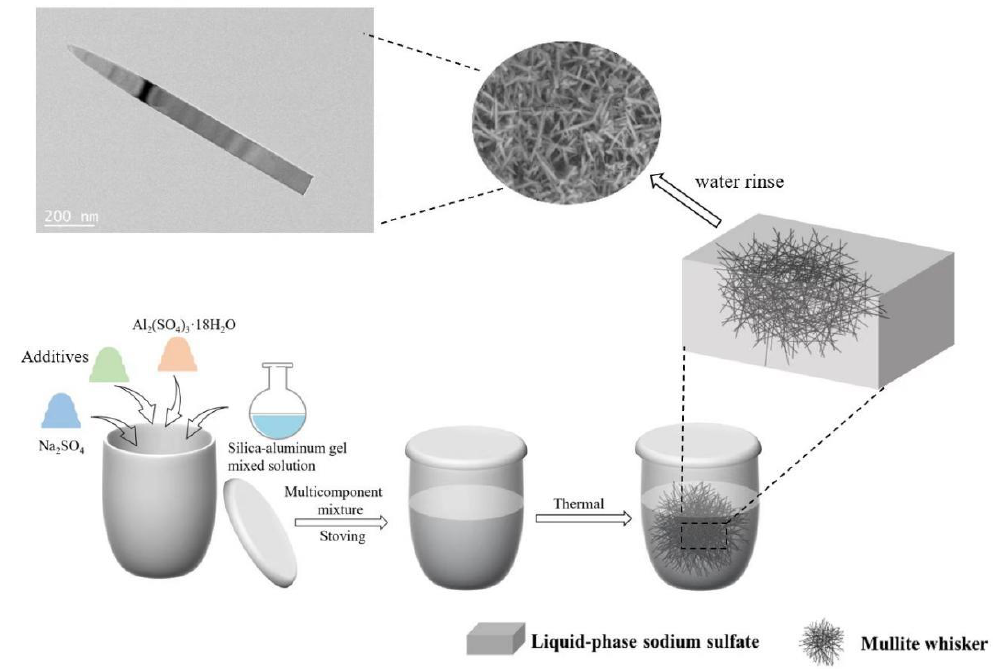
Figure 1. shows the flow chart for the preparation of mullite whiskers. Figure 1. Shows the flow chart for the preparation of mullite